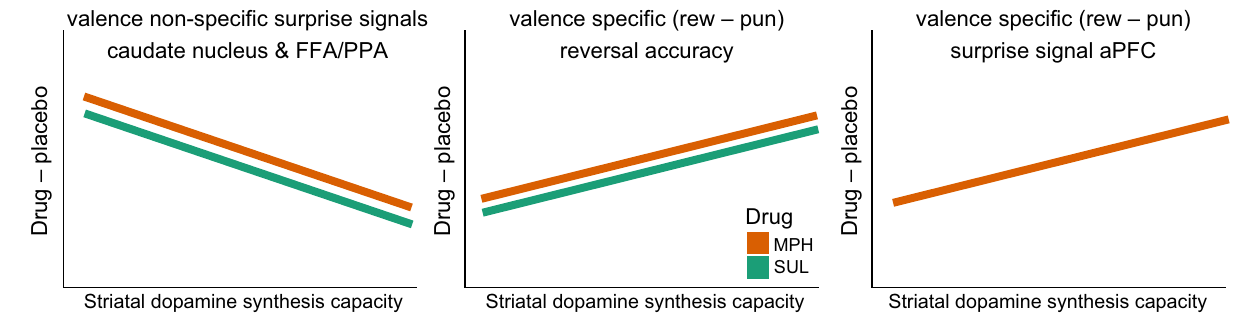
Fig. 7 | Schematic of key fi ndings. The dopaminergic drugs methylphenidate and sulpiride boosted outcome surprise signals in the caudate nucleus and stimulus-speci fi c visual association cortex in ‘ low striatal dopamine ’ partici- pants (left panel). This was accompanied by the drugs boosting punishment compared with reward-based reversal learning in the “ low striatal dopamine ” participants, while boosting relative reward-based reversal learning to a